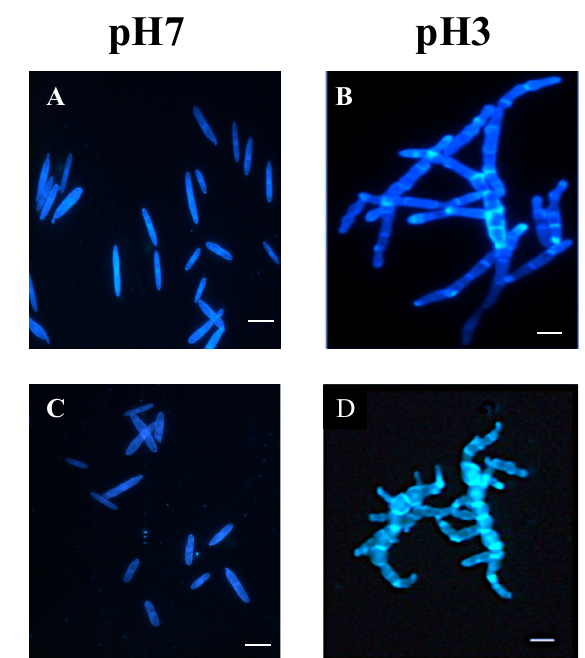
Figure 2. Cell morphology of U. maydis wild type and mutant strains grown in pH 7 or pH 3 minimal medium. ( A ) Wild type cells grown in pH 7 minimal medium and ( B ) grown in pH 3 medium; ( C ) cells of ∆ cda1 mutant grown al pH 7; ( D ) mutant grown at pH 3. All cells were stained with calcofluor white and photographed under UV light. Magnification bars, 10 μ m.